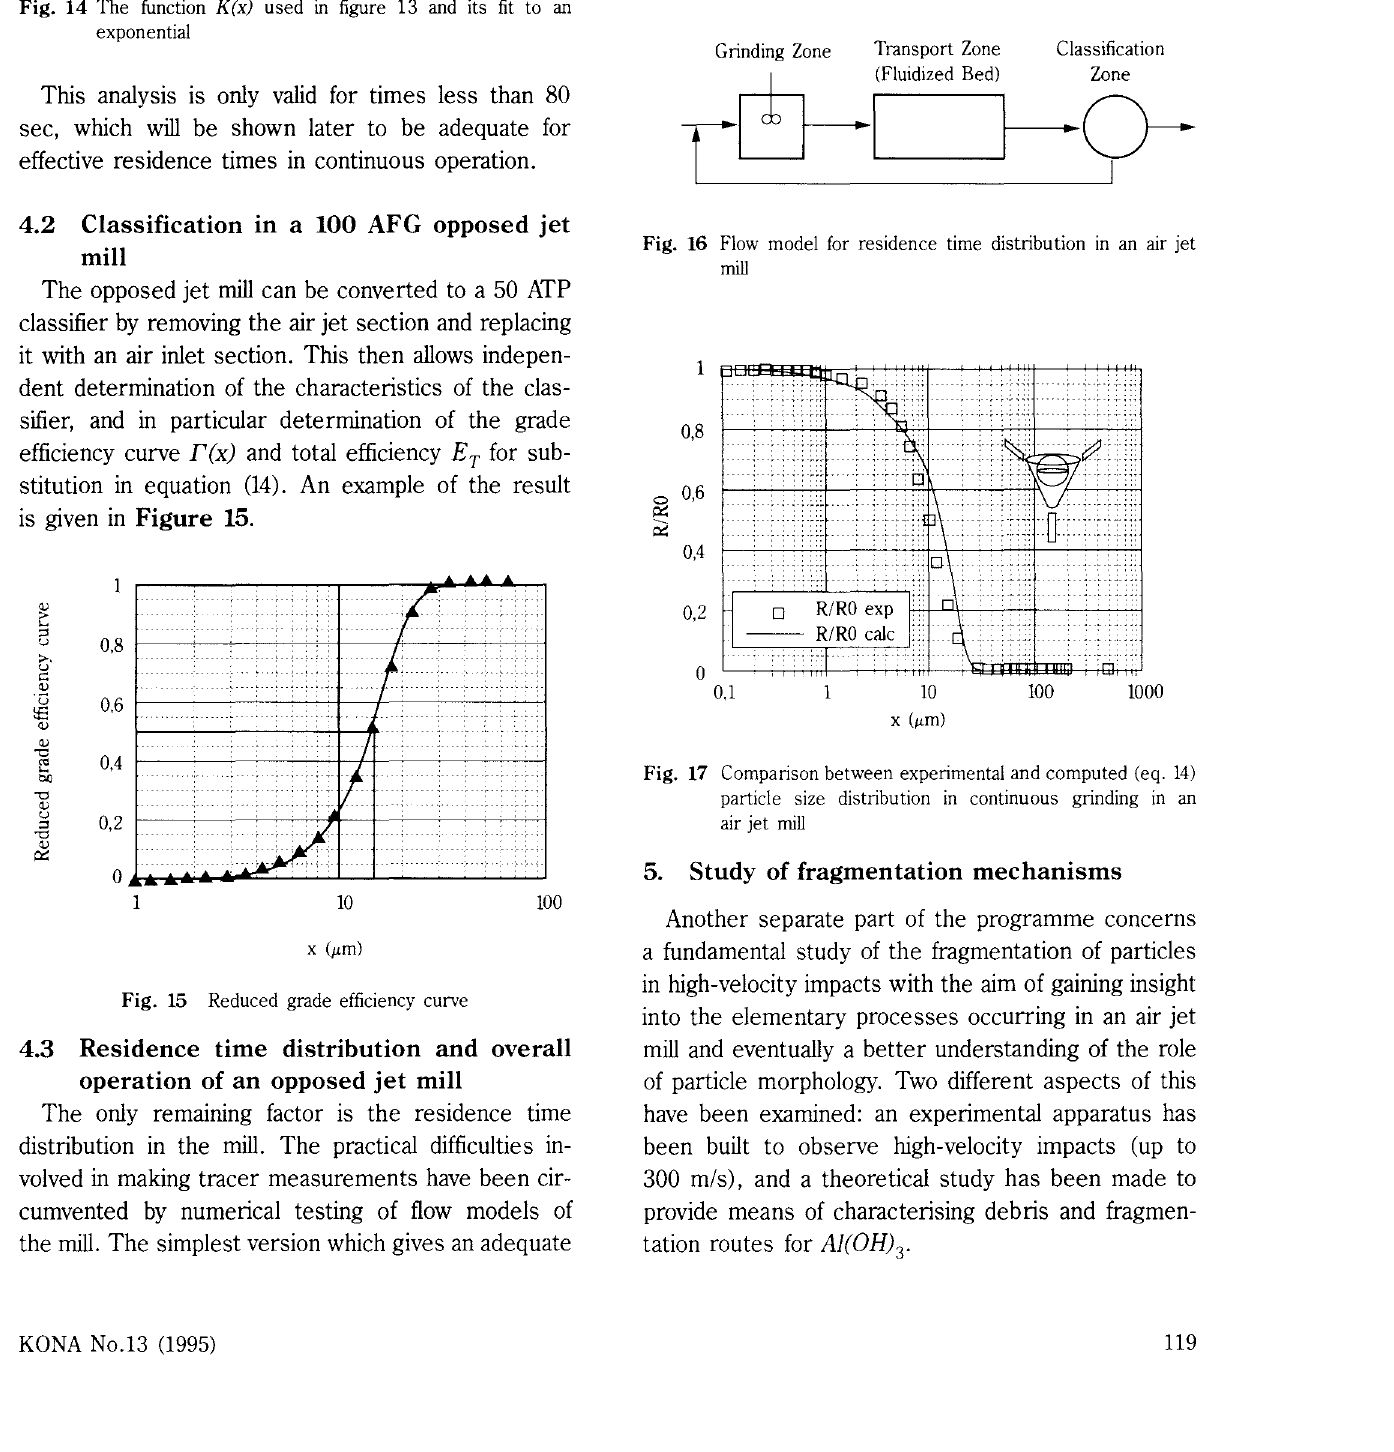
Fig. 14 The function K(x) used in figure 13 and its fit to an exponential